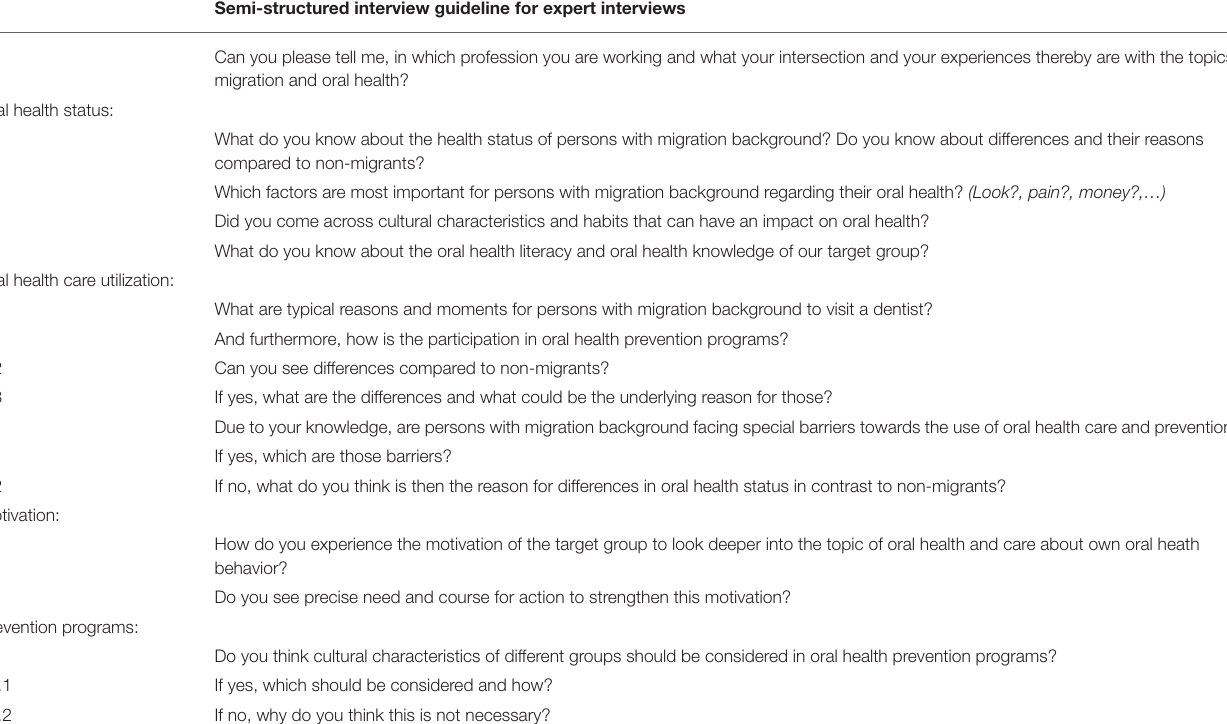
TABLE 1 | Semi-structured interview guideline for expert interviews. Semi-structured interview guideline for expert